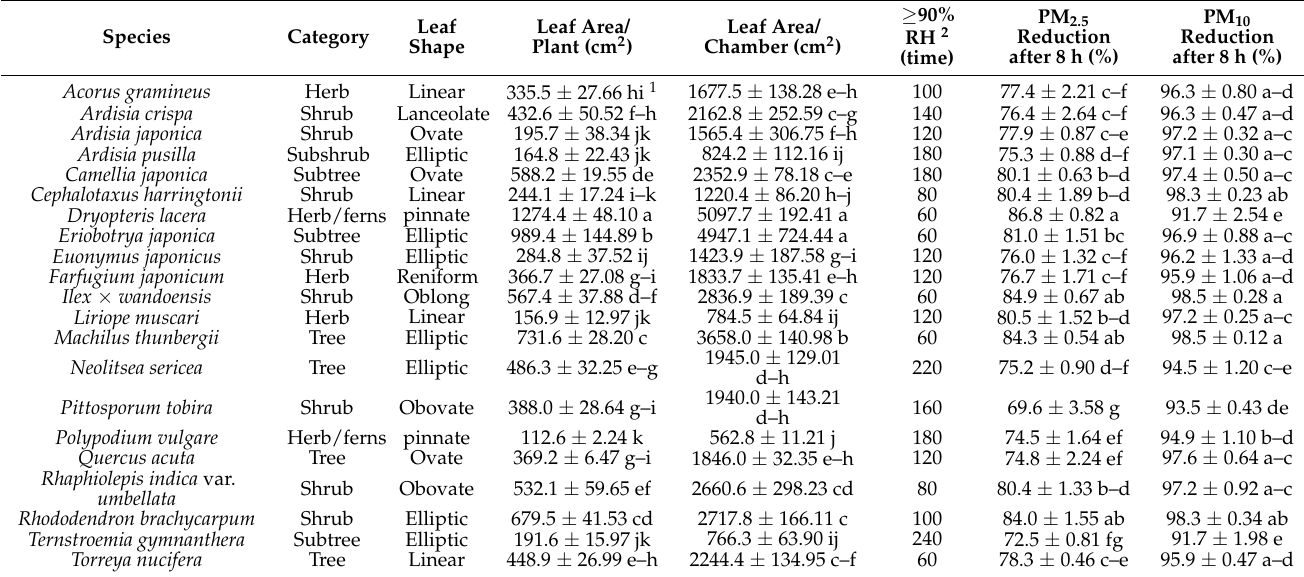
Table 2. Morphological characteristics of 21 plant species investigated regarding the reduction in mass concentration of particulate matter